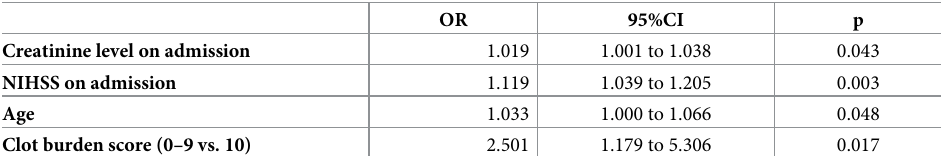
Table 5. Independent predictors of unfavorable long-term outcome a (mRS) in the total cohort. OR